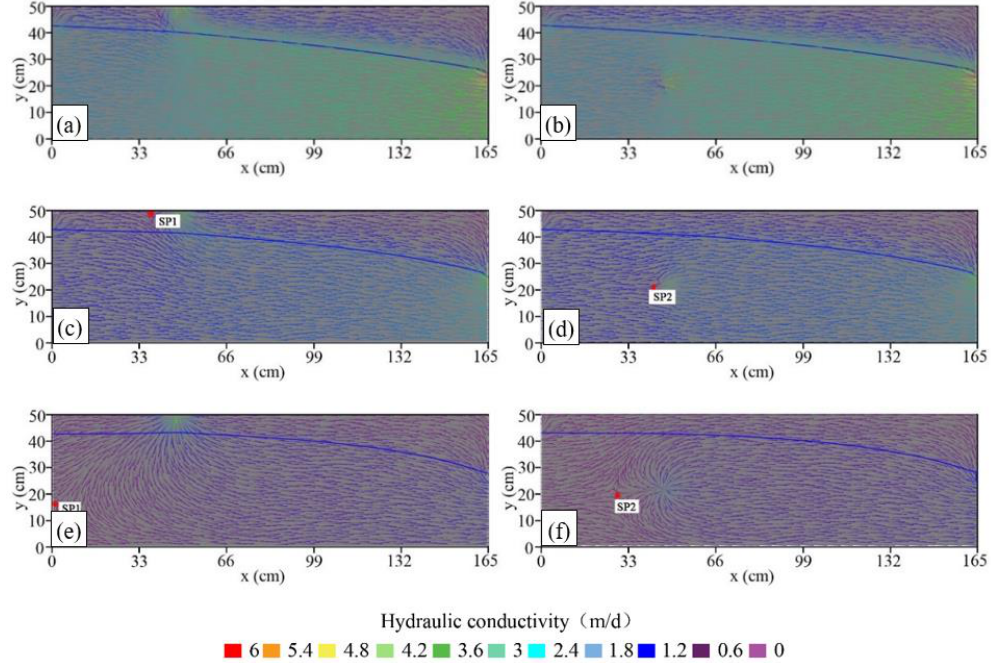
Figure 8. Flow fields when artificially recharged through the infiltration basin (left side figures) and injection well IW3 (right side figures) with different length-decay exponents. The length-decay exponents in ( a ) and ( b ) were set to 0.005 m − 1 . The length-decay exponents in ( c ) and ( d ) were set to 0.01 m − 1 . The length-decay exponents in ( e ) and ( f ) were set to 0.02 m − 1 . The blue lines in the figures represent the water